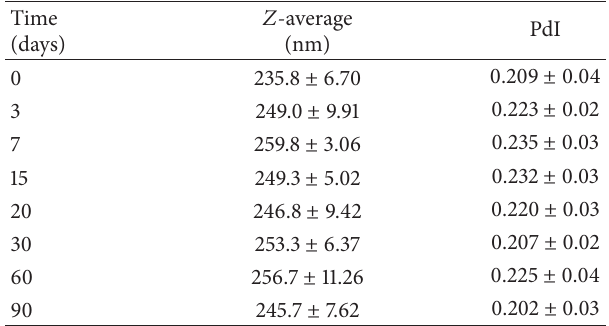
Table2: 𝑍 -averagediameterandpolydispersityofNAFduringtime.